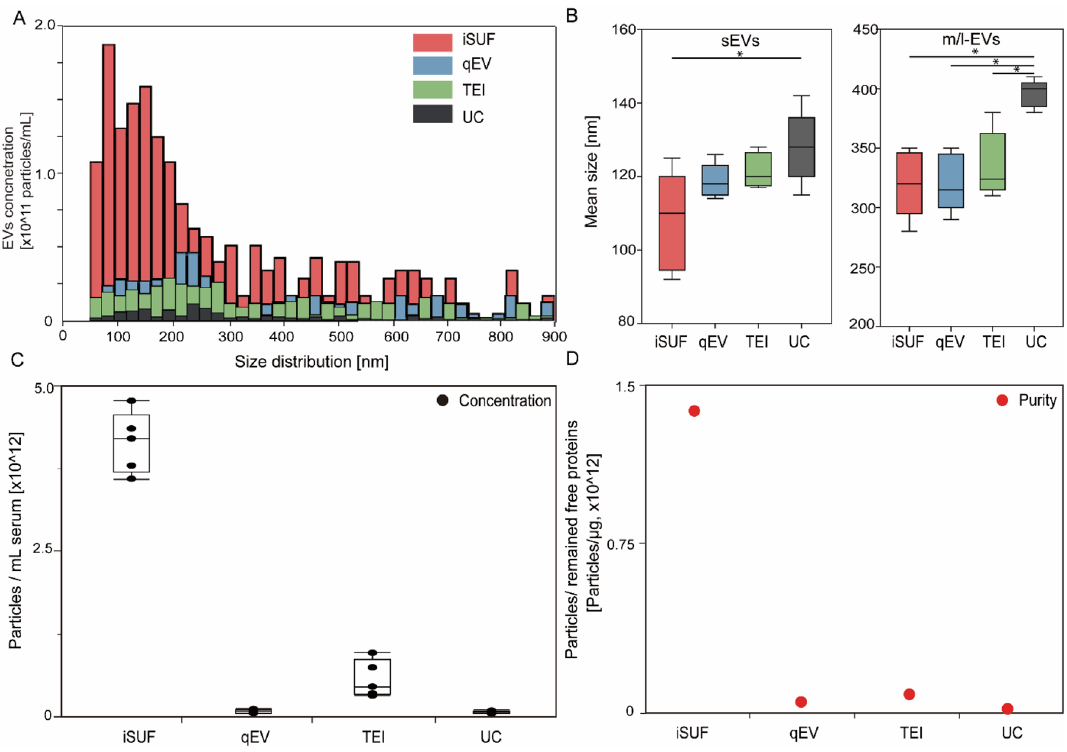
Figure 3. Comparison of size distribution and purity of EVs isolated with different platforms. ( A ) Size distribution of EVs isolated from serum using different platforms. iSUF demonstrated the highest EV concentration within the 70 nm–1 μm size range. ( B ) Left. Mean size boxplot for small EVs (sEVs, < 200 nm, measured by NP150). Right. Mean size boxplot for medium/large EVs (m/l-EVs, > 200 nm, measured by NP300). ( C ) Concentration of isolated EVs using different platforms. Black boxplots were the absolute concentration of EVs isolated from 0.5 mL of serum. ( D ) Red dots were purities defined as the EV concentration divided by the remaining free protein concentration. iSUF isolated EVs from serum most efficiently with high purity (n = 5; p < 0.05) (mean ± STD), qEV yielded pure EVs, but at a lower concentration, TEI isolated more EVs but at relatively low purity, and UC recovered EVs with the lowest concentration and